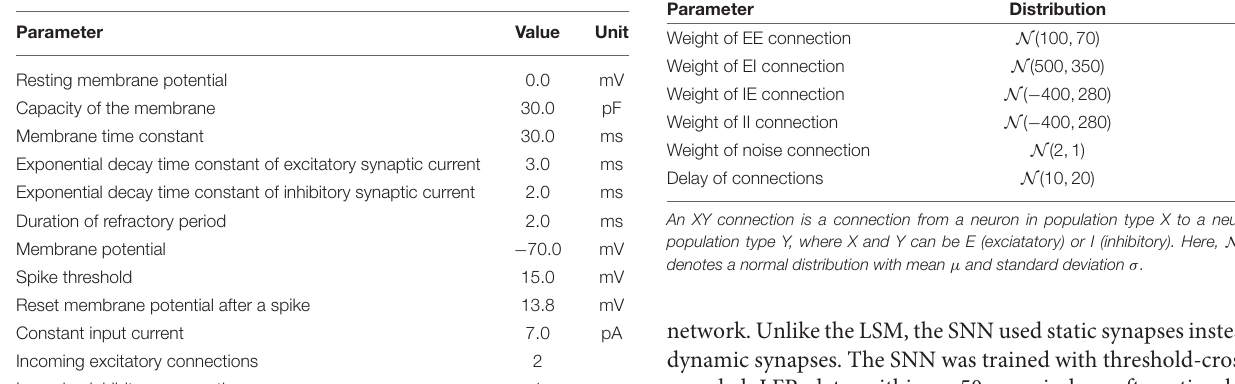
TABLE 1 | Parameters of leaky integrate-and-fire neuron model with exponential-shaped postsynaptic currents using the NEST simulator.